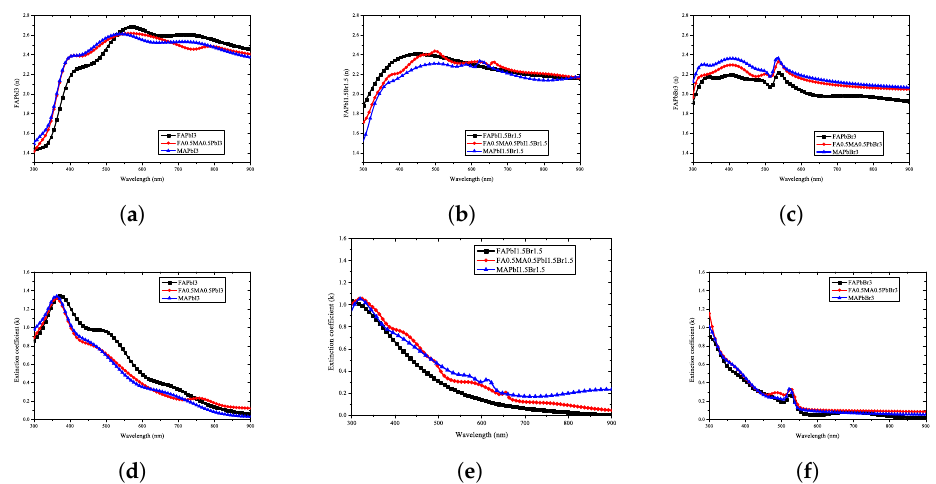
Figure 15. Results of optical properties with MA ratio of quaternary perovskite material: ( a – c ) refractive index, ( d – f ) extinction